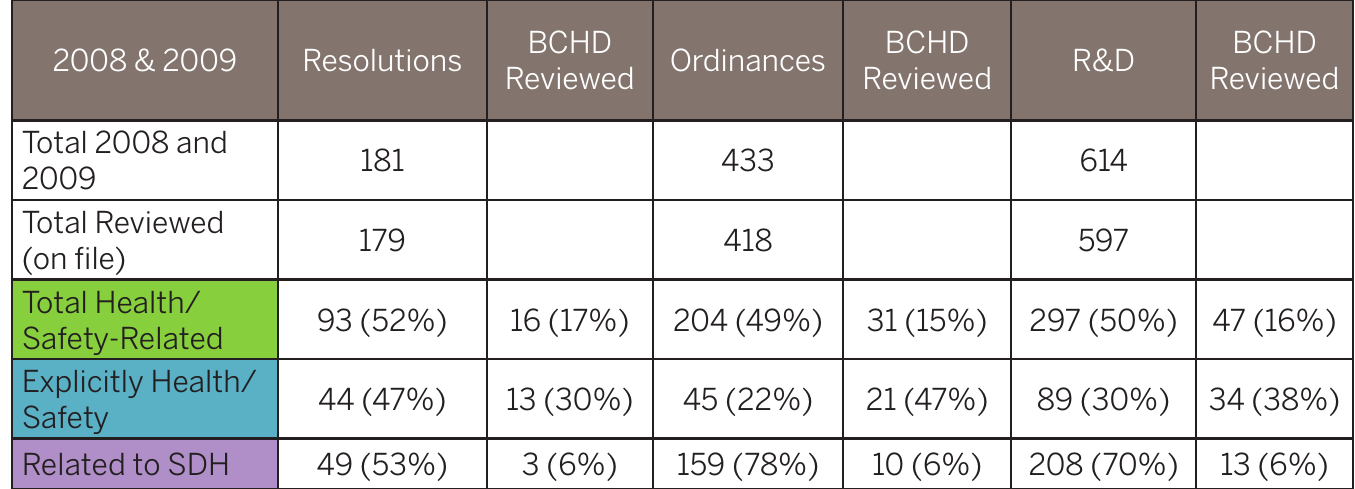
Figure 1: Summary of 2008 & 2009 Polices Referred for Health Review